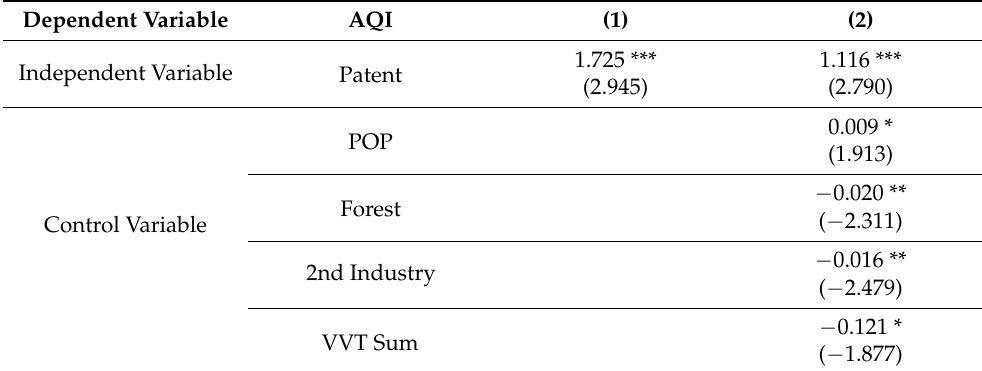
Table 8. Innovation and AQI—robustness test (only air quality directly related invention patents